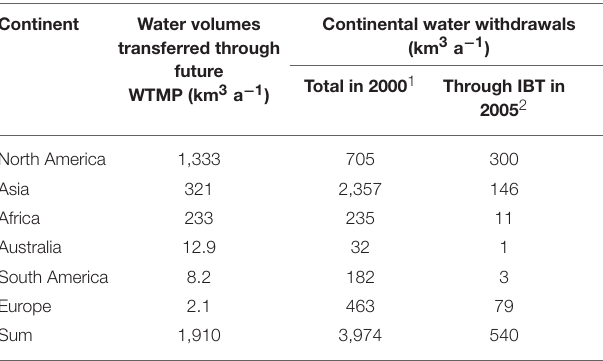
TABLE 2 | Water volumes transferred in future WTMP vs. volumes of continental water withdrawals and total discharge to oceans (per